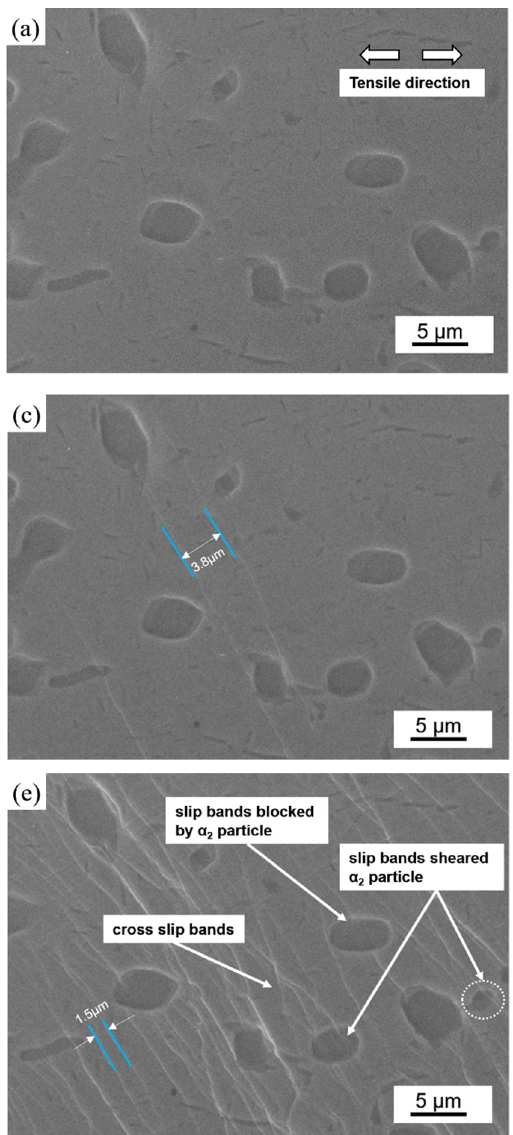
Figure 5. The SEM images during the in situ tensile test according to different stages in Figure 4: ( a )